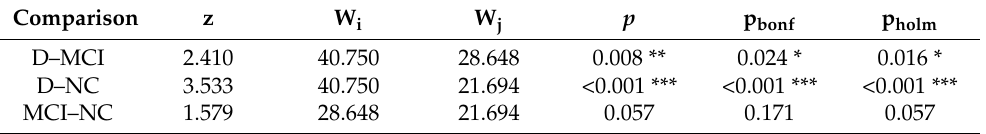
Table 6. Dunn post-Hoc comparison of PVWM hyperintensities between D–MCI, D–NC, and MCI– NC groups.